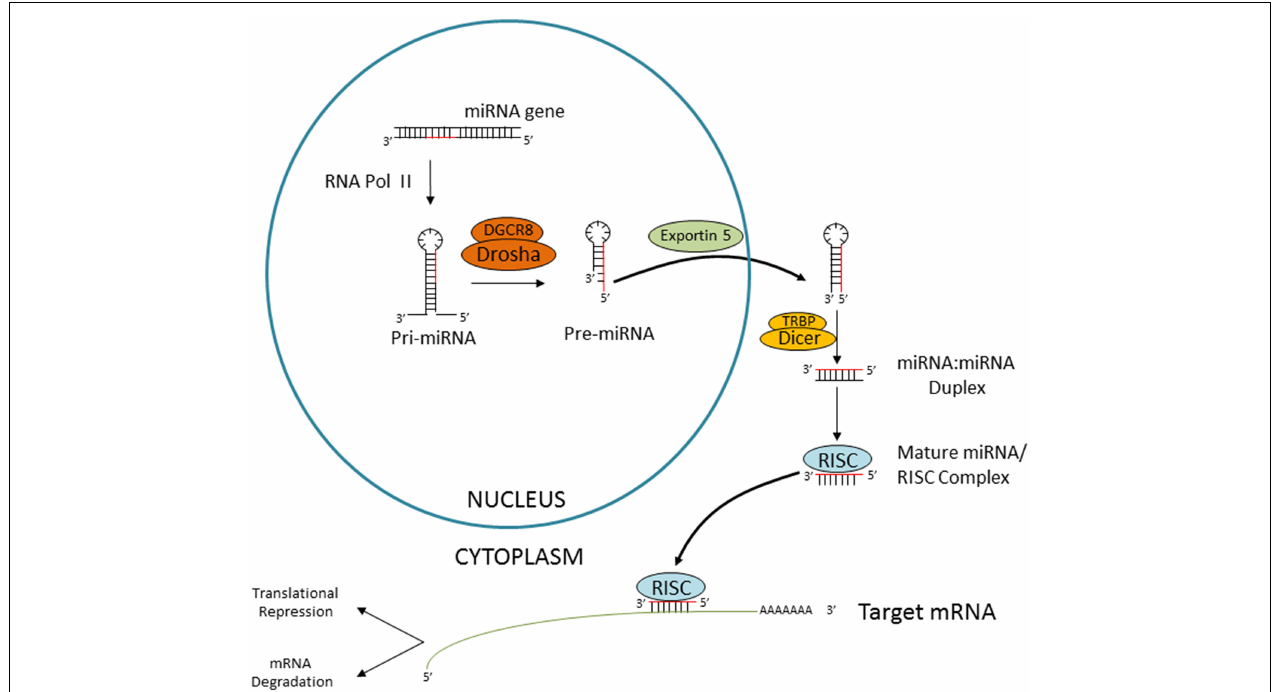
FIGURE 1 | Canonical miRNA biogenesis. Schematic representation of the Dicer-dependent miRNA generation pathway. miRNA genes are transcribed by RNA polymerase II, followed by nuclear processing by the microprocessor complex (consitituted by DGCR8 and Drosha), cytoplasmatic export by